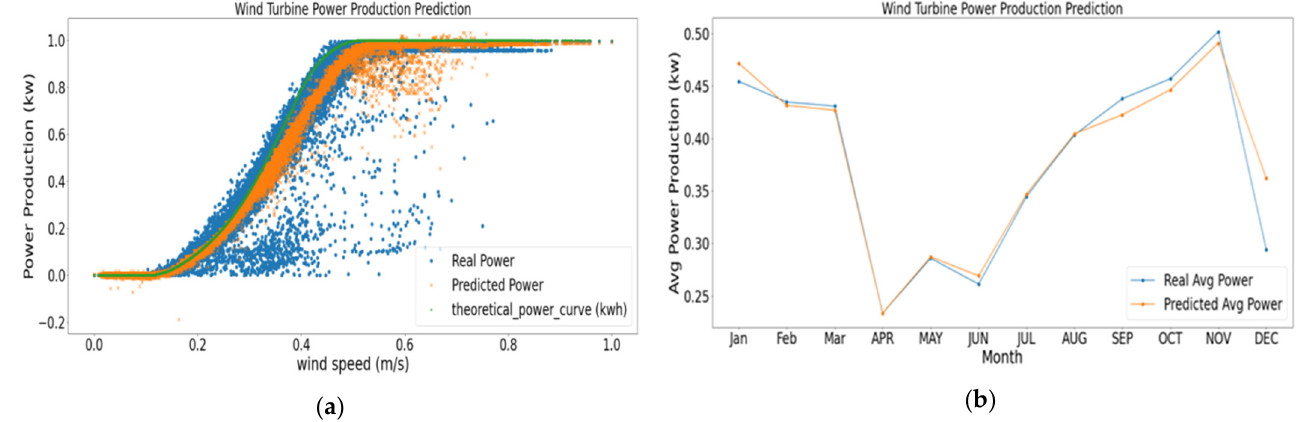
Figure 14. ( a ) Scatter plot depicting the relationship between the wind speed (m/s) and the power production (kW) of the turbine when using decision tree regression. ( b ) Predicted average power in comparison with real average power of the turbine (kW) when using decision tree regression.